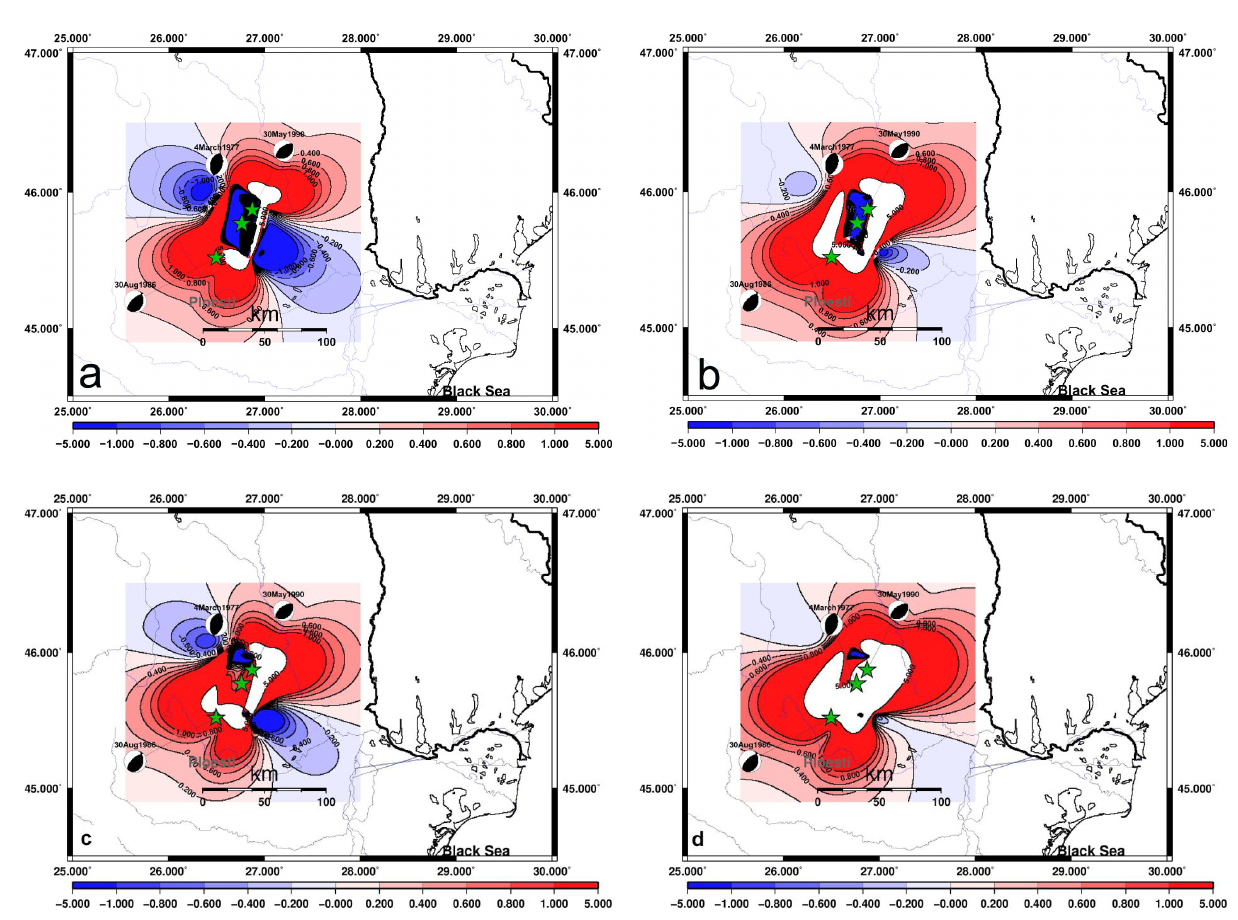
Fig. 4. Maps of combined 1 CFF for the 1977 and 1986 earthquakes for optimally oriented faults to regional compression (N307 ◦ E) at depth of 89km (hypocentral depth of 1990 event). (a) Friction µ 0 =0.4). (b) Friction µ 0 =1. Colour palette of stress values is linear in the range of − 1 to +1bar (1bar=100kPa). Blue areas indicate unloading, red areas indicate loading, respectively. White colour indicates area where transferred stress > 5 bar and black colour the area where stress reduction was < − 5bar. Green stars show the earthquake epicentres. (c) Map of combined 1 CFF for regional compression N323 ◦ E and µ 0 =0.4. (d) Map of combined 1 CFF for regional compression N323 ◦ E and µ 0 =1.